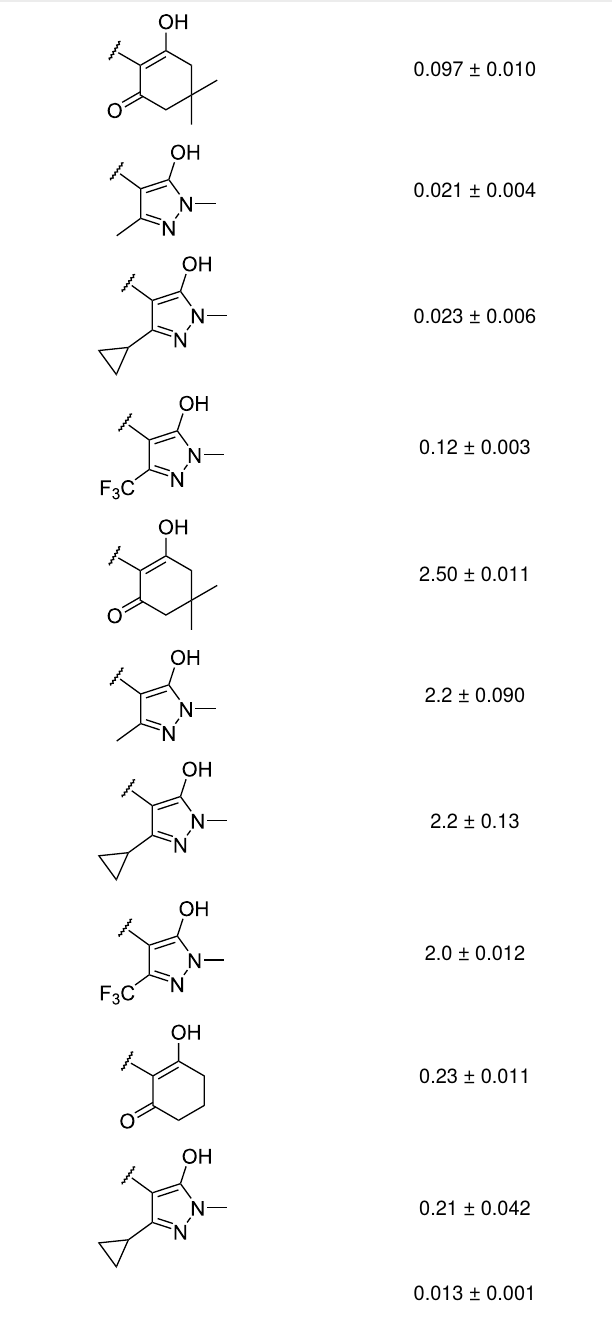
Table 2: Chemical structures of title compound II , III and their biological activity against At HPPD.